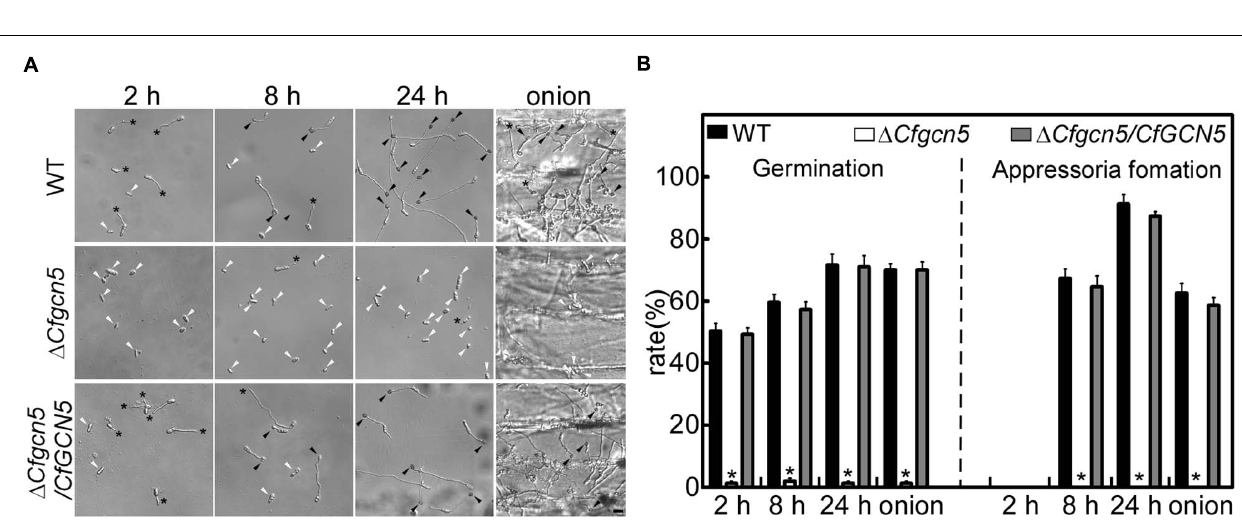
FIGURE 4 | CfGcn5 is involved in germination and appressoria formation. (A) The conidia of WT, (cid:49) Cfgcn5, and (cid:49) Cfgcn5 / CfGCN5 were inoculated on artificial hydrophobic surfaces and onion epidermis, respectively. Germination and appressoria formation were observed after inoculation on hydrophobic surfaces at different time points (2, 8, and 24 h), and on onions epidermis (24 h). Asterisks indicate germ tubes, black arrows indicates appressoria, and white arrows indicates conidia. Bar = 10 µ m. (B) Statistical analysis of germination and appressoria formation rates. Error bars represent standard deviations (SD) of three replicates and asterisks indicate significant differences ( p < 0.01). The experiments were repeated three times with three replicates each time, and more than 100 conidia were counted per replicate.